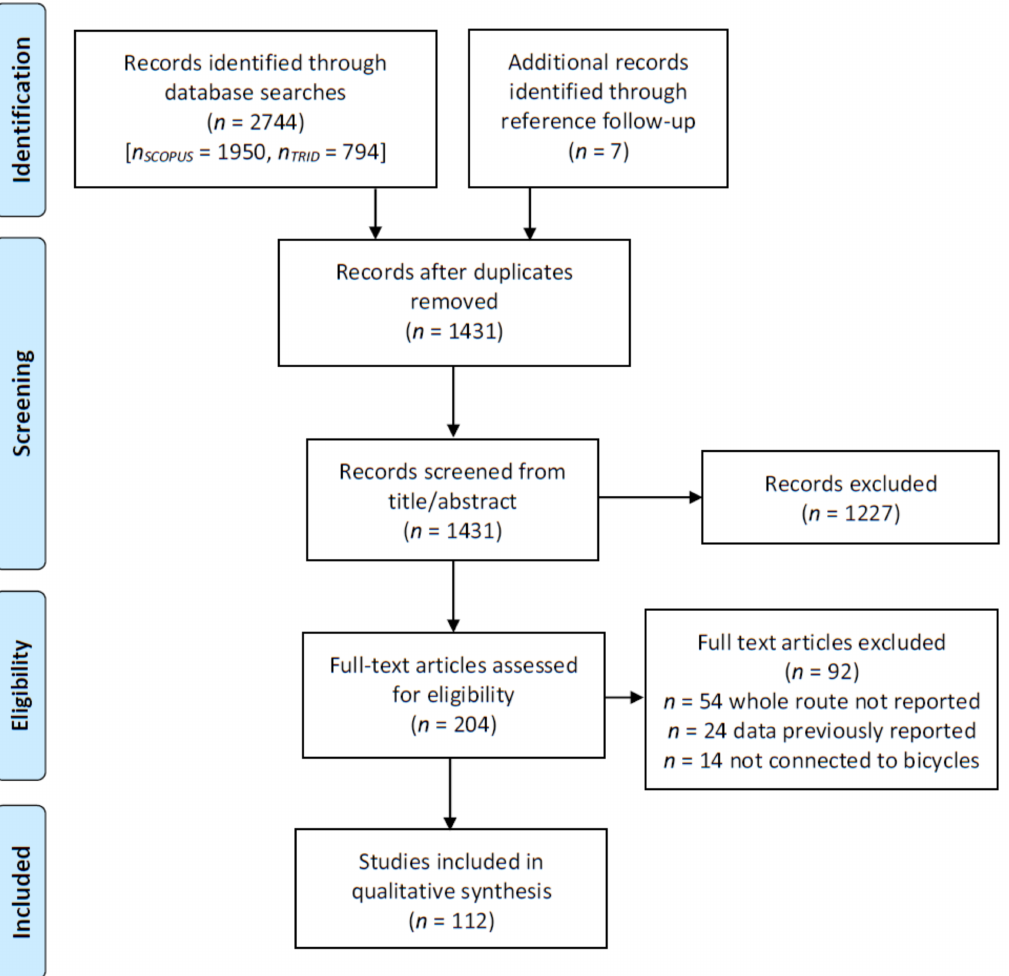
Figure 1. Pathway diagram of included and excluded articles in